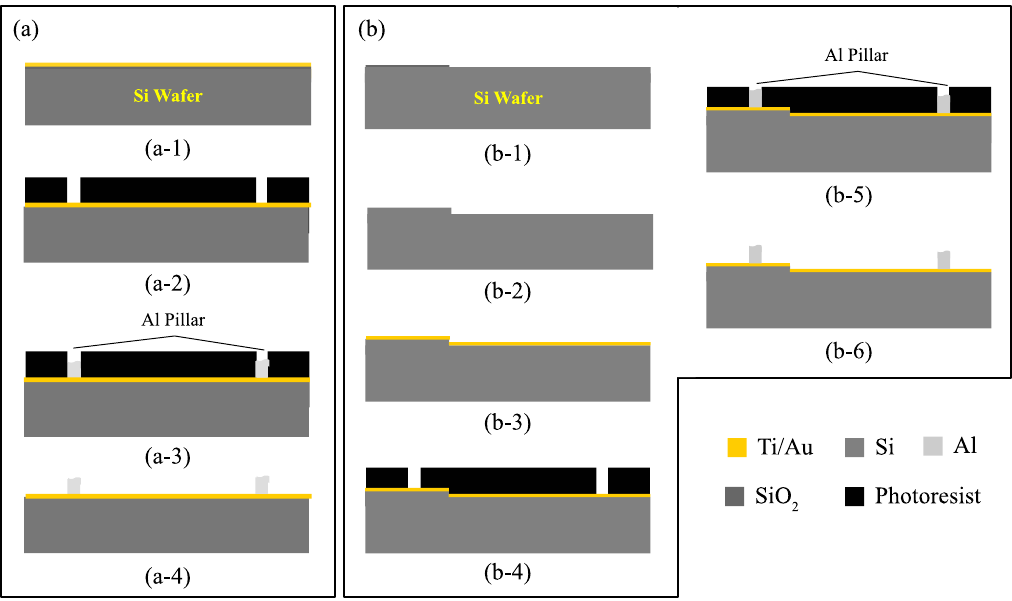
Figure 2. Sample fabrication process of ( a ) patterned electroplating experiment and ( b ) patterned electroplating on microstructured wafer; ( a-1 ) seed layer sputter deposition on a Si wafer; ( a-2 ) negative photoresist AZ125NXT patterning for electroplating; ( a-3 ) Al patterned electroplating; ( a-4 ) photoresist stripping; ( b-1 ) thermal oxidation and SiO 2 patterning; ( b-2 ) TMAH wet etching of Si and SiO 2 removal; ( b-3 ) seed layer sputter deposition on a Si wafer; ( b-4 ) negative photoresist AZ125NXT patterning for electroplating; ( b-5 ) Al patterned electroplating; ( b-6 ) photoresist